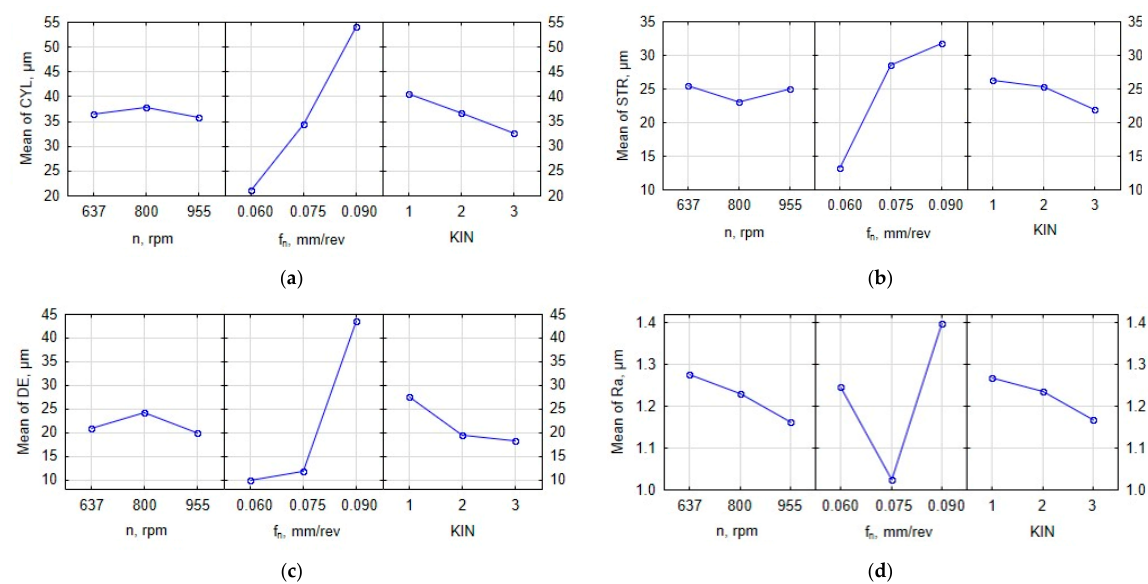
Figure 9. Main effects plot for: ( a ) the cylindricity error; ( b ) the straightness error; ( c ) the diameter error; and ( d ) the parameter R a . error; and ( d ) the parameter R a .